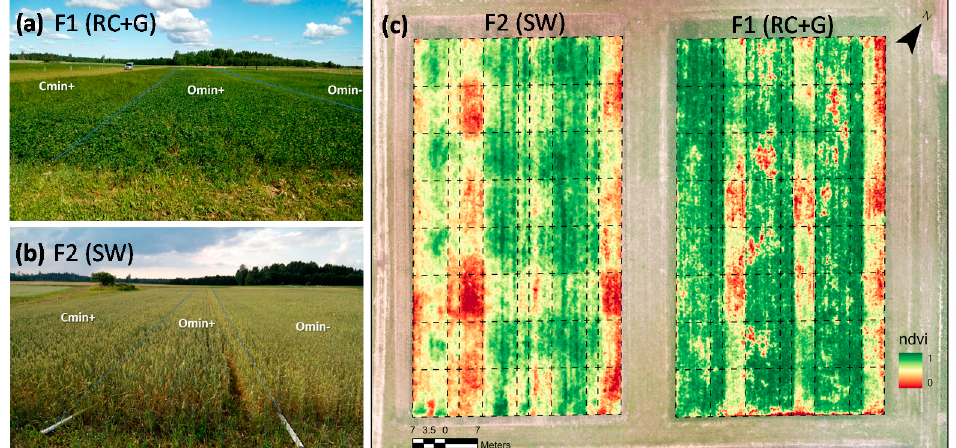
Figure 3 . Interpretation diagrams representing onsite crop VPTs and the calculation of VIs per the image captured on 10 July ( a ) Field 1: red clove + grass (RC + G) with CM treatment. ( b ) Field 2: Spring wheat (SW) field with CM treatment. ( c ) Normalized Difference Vegetation Index (NDVI) image captured of F1 (RC + G) and F2 (SW)